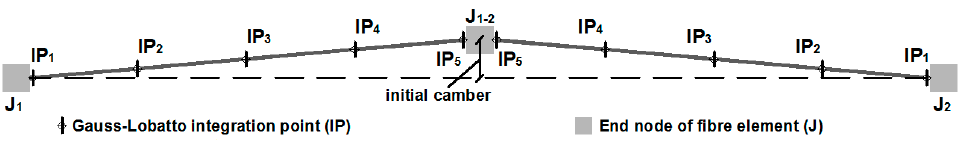
Figure 8. Model of a steel brace with two FEs and bilinear initial camber (adapted from [15]).